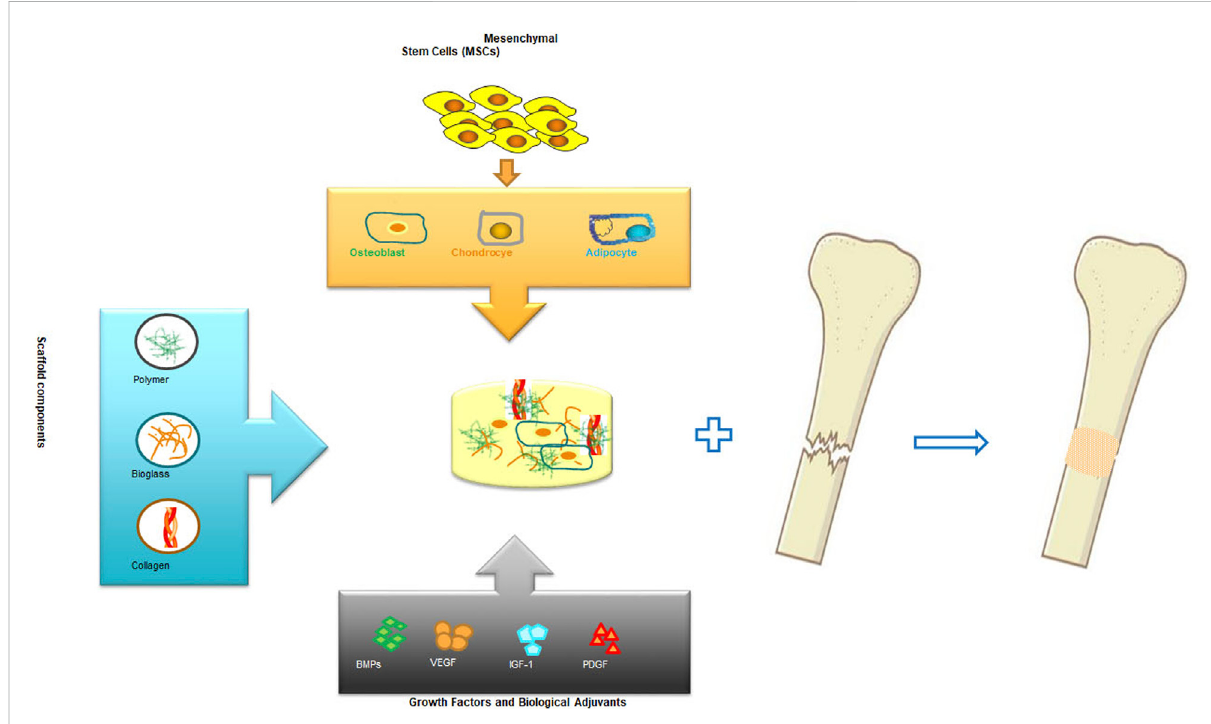
FIGURE 1 Schematic representation of a bone engineering including its major